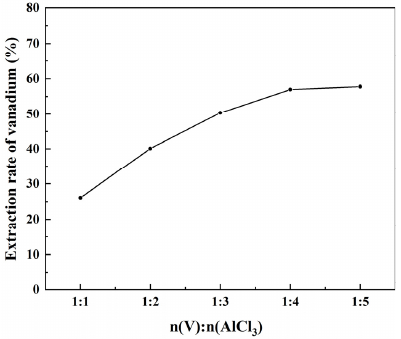
Figure 7. E ff ects of AlCl 3 dosage on the vanadium extraction rate. Figure 7. Effects of AlCl 3 dosage on the vanadium extraction rate. With an increasing AlCl 3 dosage, the vanadium extraction rate increased, while the purity of VOCl 3 remained above 99%. Thus, considering the vanadium extraction rate, Table 4. Effects of AlCl 3 dosage on the purity of VOCl 3 . VOCl 3 purity, and cost, we identi fi ed the optimum V:AlCl 3 molar ratio as 1:5, which cor- responded to a VOCl 3 purity of 99.59%. Table 4. E ff ects of AlCl 3 dosage on the purity of VOCl 3 .